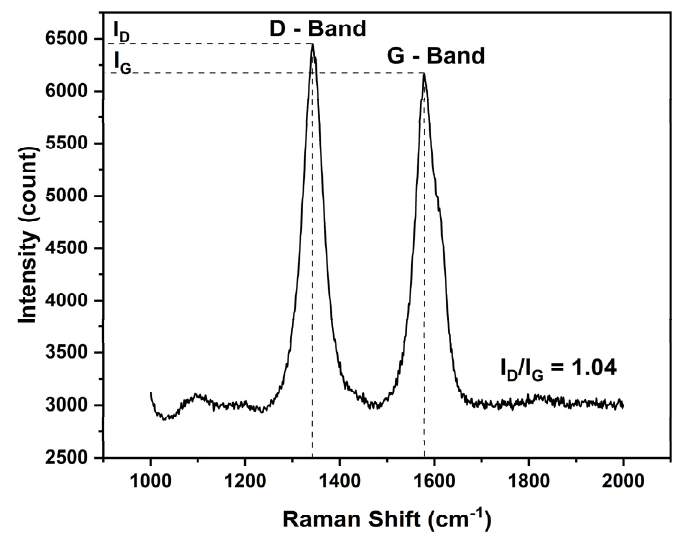
Figure 4. Raman spectroscopy of synthesized MWCNTs.